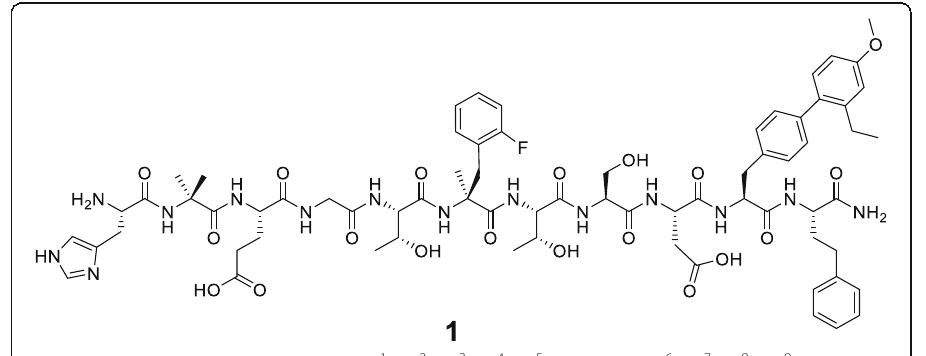
Fig. 1 Sequence of lead peptide 1 , with His 1 -Aib 2 -Glu 3 -Gly 4 -Thr 5 -( α -Me)Phe(2-F) 6 -Thr 7 -Ser 8 -Asp 9 -(2 ′ -Et, 4 ′ - OMe)BIP 10 -homoPhe 11 -NH 2 (Haque et al., 2010a). All amino acids are in L-configuration and given in the three-letter code. Et, ethyl; Me, methyl; BIP, 4, 4 ′